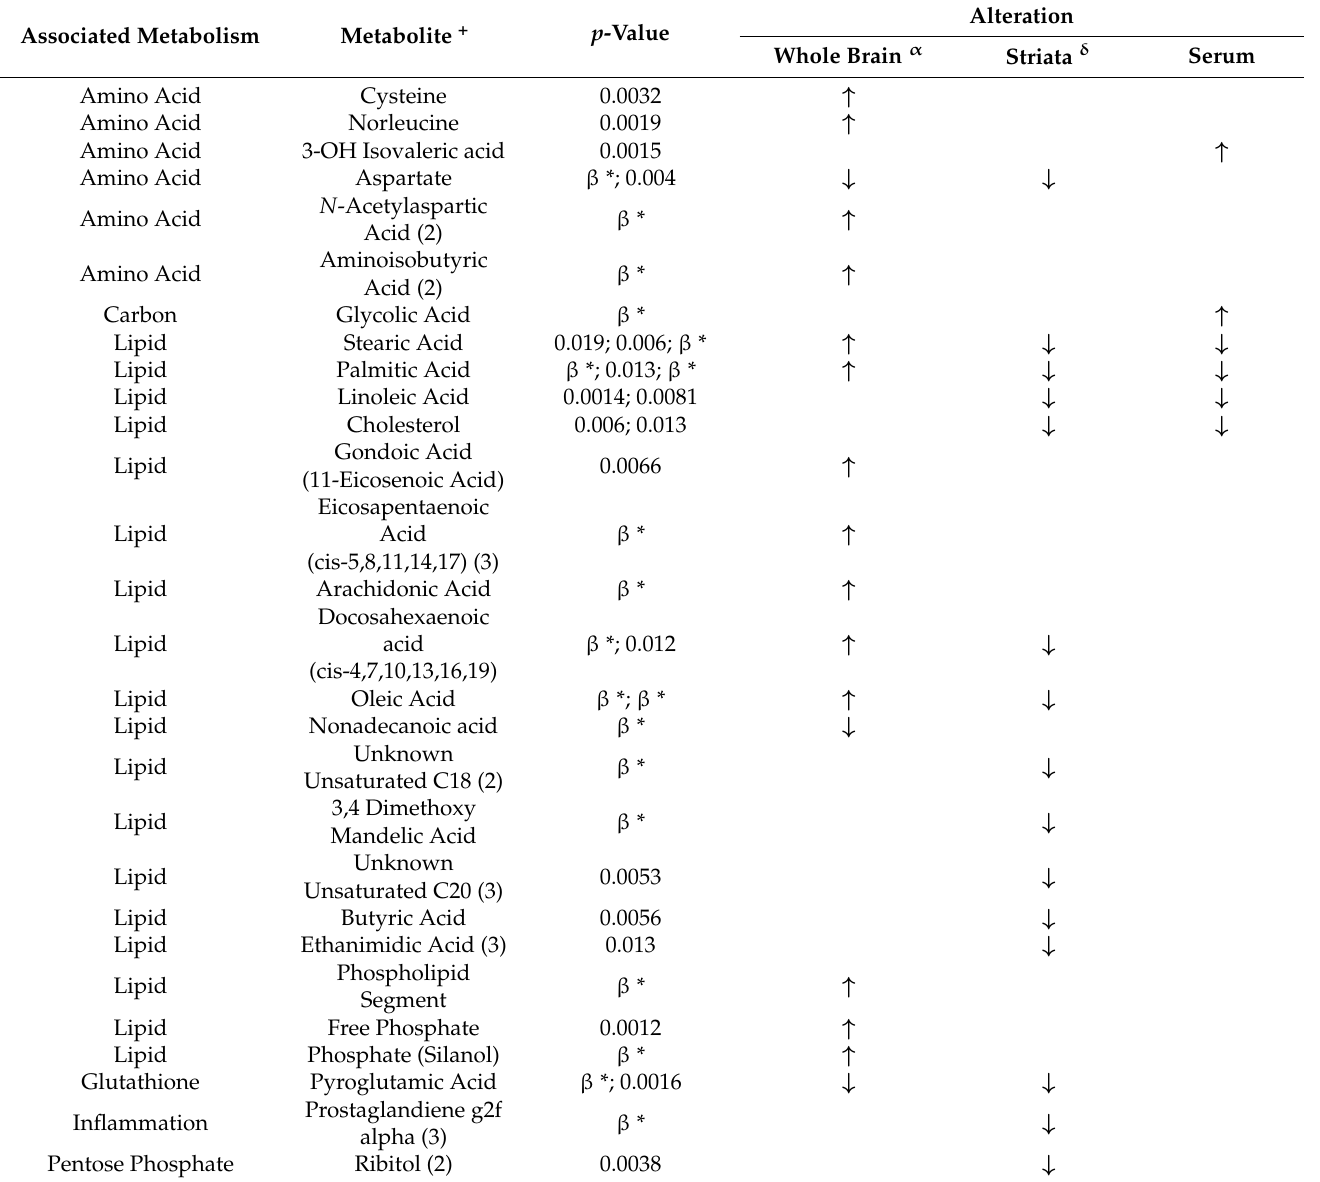
Table 3. Imipramine metabolic alterations in serum and brain